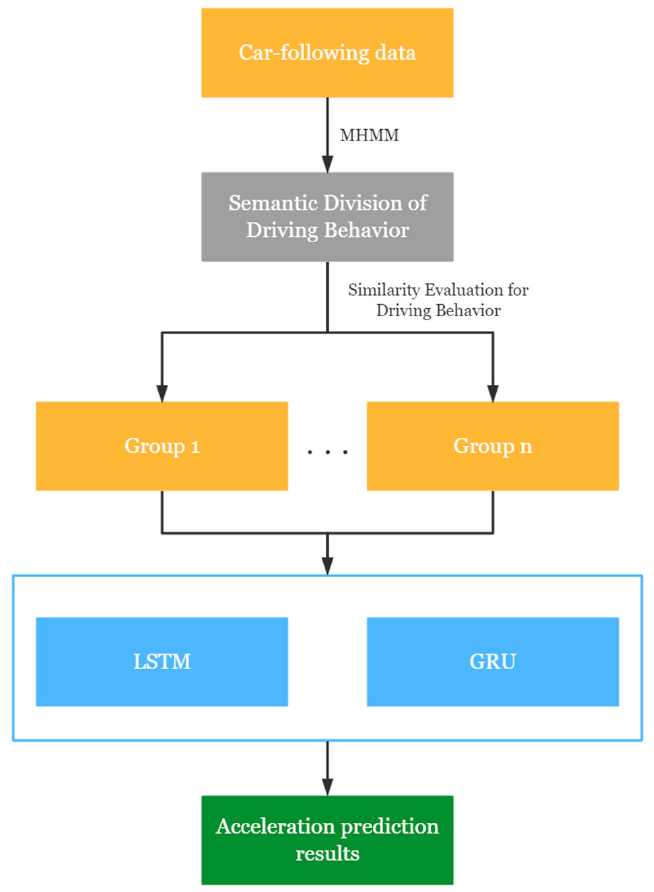
Figure 1. Flowchart of the proposed vehicle acceleration prediction